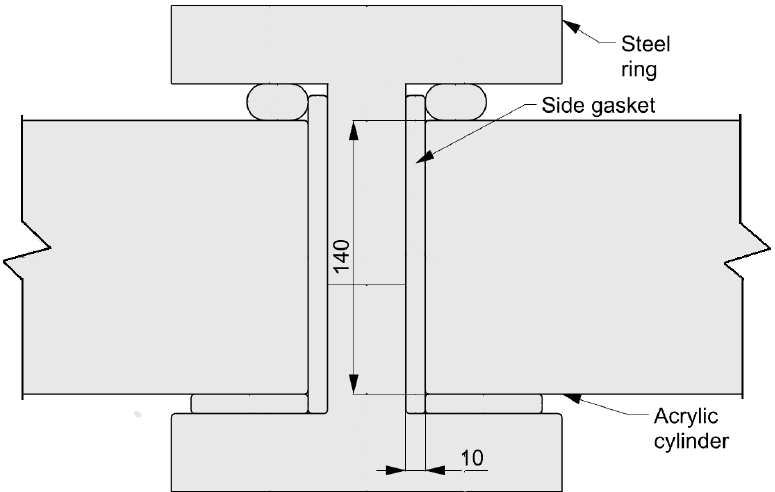
Figure 3. Scheme of a joint between the acrylic cylinder and the supporting steel ring (dimensions in mm).